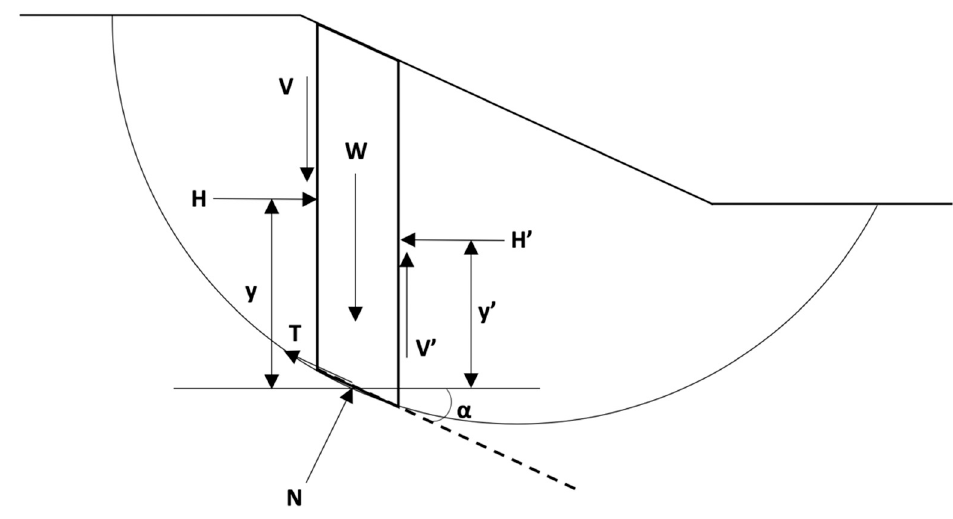
Figure 5. The unknown parameters in the slice method [17].